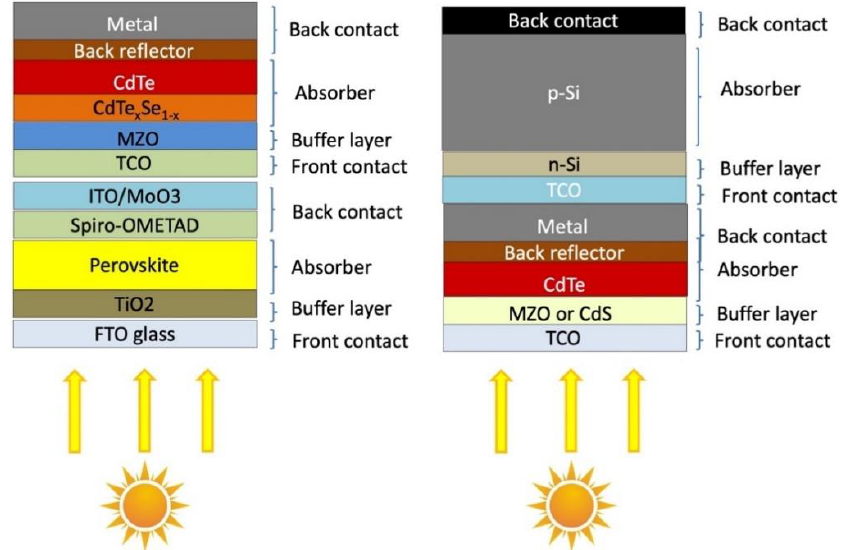
Figure 15. Schema of a perovskite/CdTe ( left ) and Si/CdTe ( right ) tandem solar cells. It is crucial, for an optimized tandem device, to align and tune the two different absorber band gaps. Perovskites are perfect in this sense since their band gap can